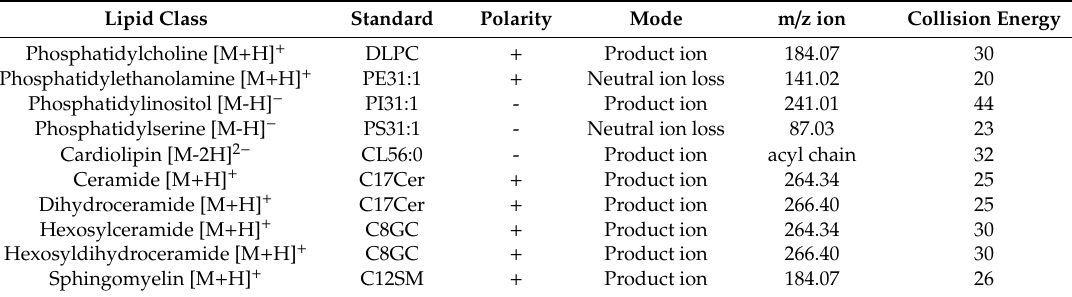
Table 1. MS detection conditions for the di ff erent lipid